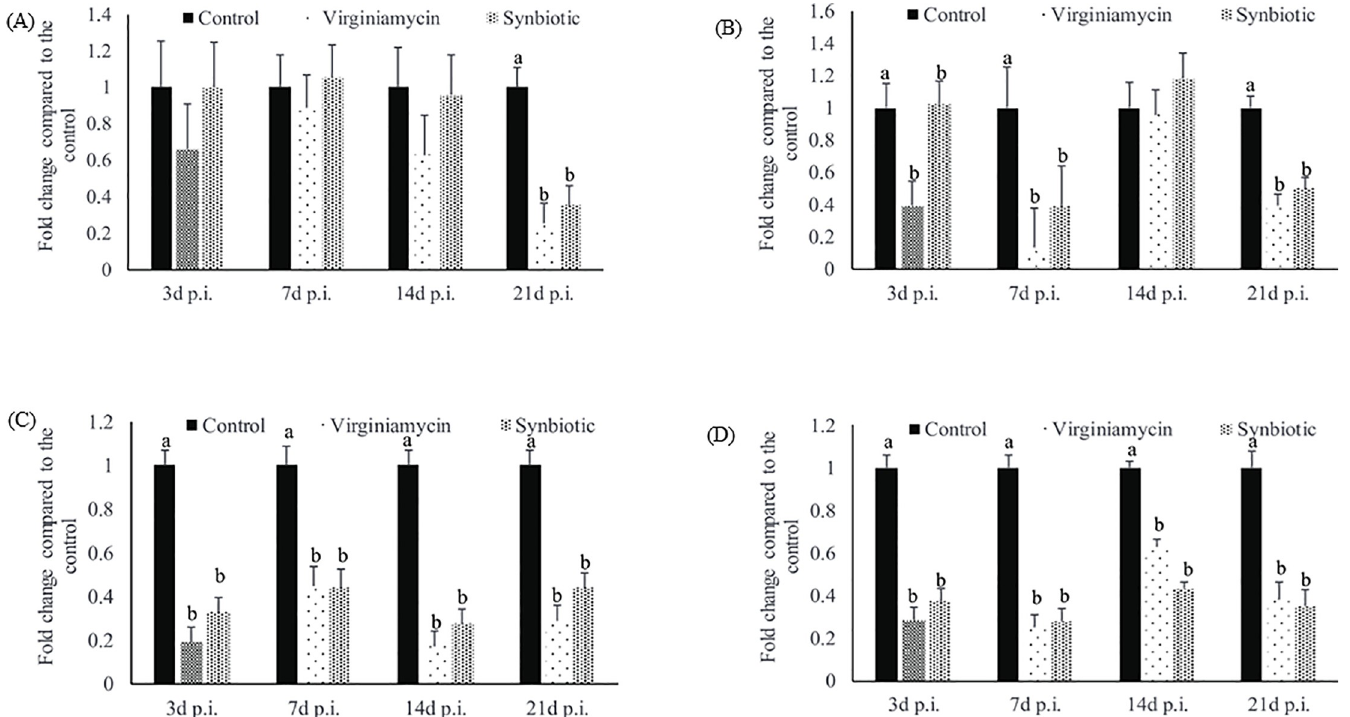
Fig 4. Effect of synbiotic supplementation on cecal tonsil mRNA content post-Salmonella infection in broilers. Birds were fed either basal diet (Control) or supplemented with 20 mg/Kg feed Virginiamycin (antibiotic) or 0.05% synbiotic product from day-of-hatch through 42d of age. At 21 d of age, birds were challenged with 1 X 10 9 CFU of S . Enteritidis . At 3, 7, 14 and 21 d post-infection (p.i.), relative IL-10 (Fig 4A), IL-1 (Fig 4B), TLR-4 (Fig 4C), and IFN γ (Fig 4D) mRNA content in cecal tonsils were analyzed from 1 bird/pen; 8 pens/diet after correcting for β -actin mRNA and normalizing to the mRNA content of the control group. Bars ( ± SEM) with no common superscript ( a, b ) differ significantly. n =